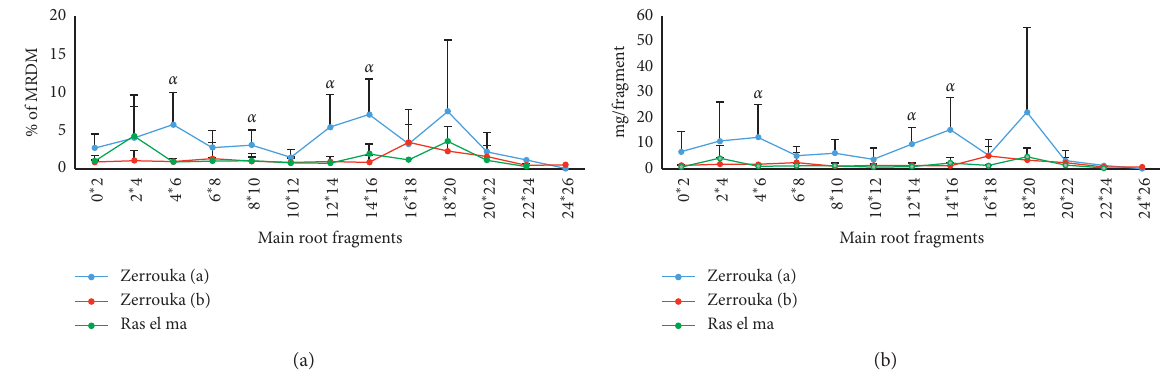
Figure 4: Distribution of dry matter of secondary roots attached to the fragment of the main root. (a) Dry mass in % of the main root dry mass (MRDM). (b) Dry mass in mg/fragment. 0 ∗ 2 means fragment 0 to 2cm. The values marked with α indicate at least one significant difference at the fragment level ( P < 0 . 05, n � 3).